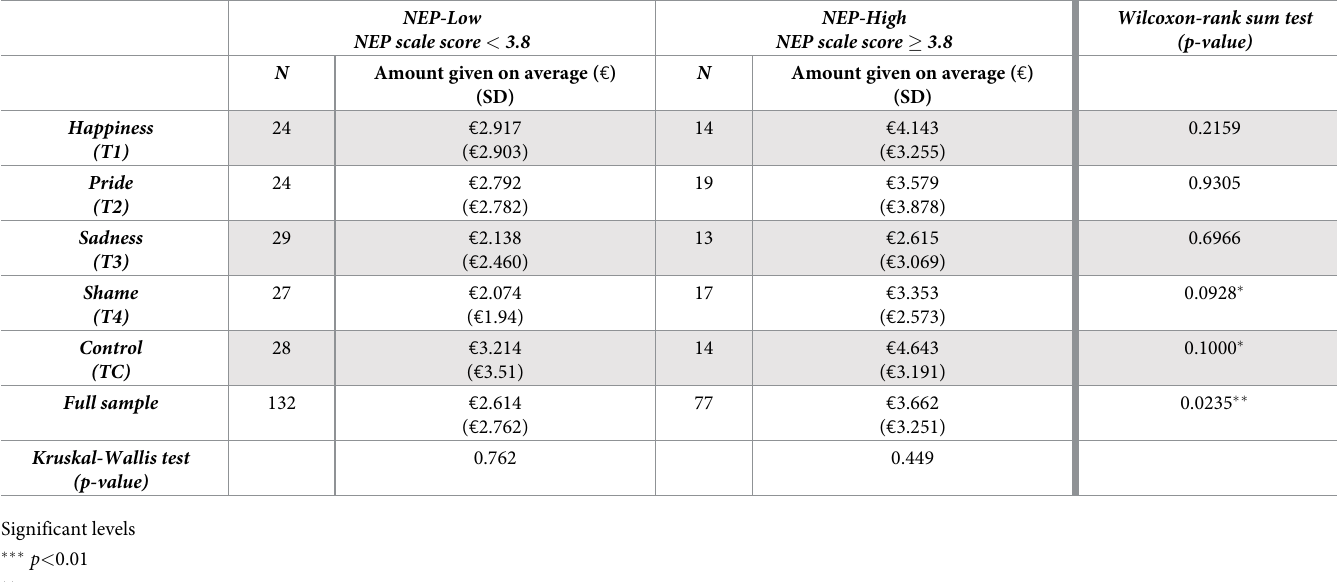
Table 7. Donation decisions and environmental awareness (by treatment and full sample).